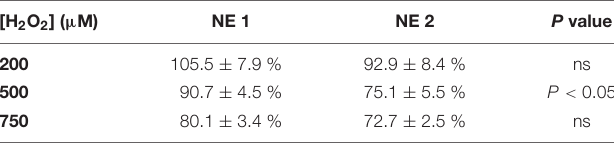
TABLE 2 | Comparison of protective effect of 50 µ M of resveratrol in NE 1 and NE 2 on cell viability, after incubation with 200, 500, and 750 µ M H 2 O 2